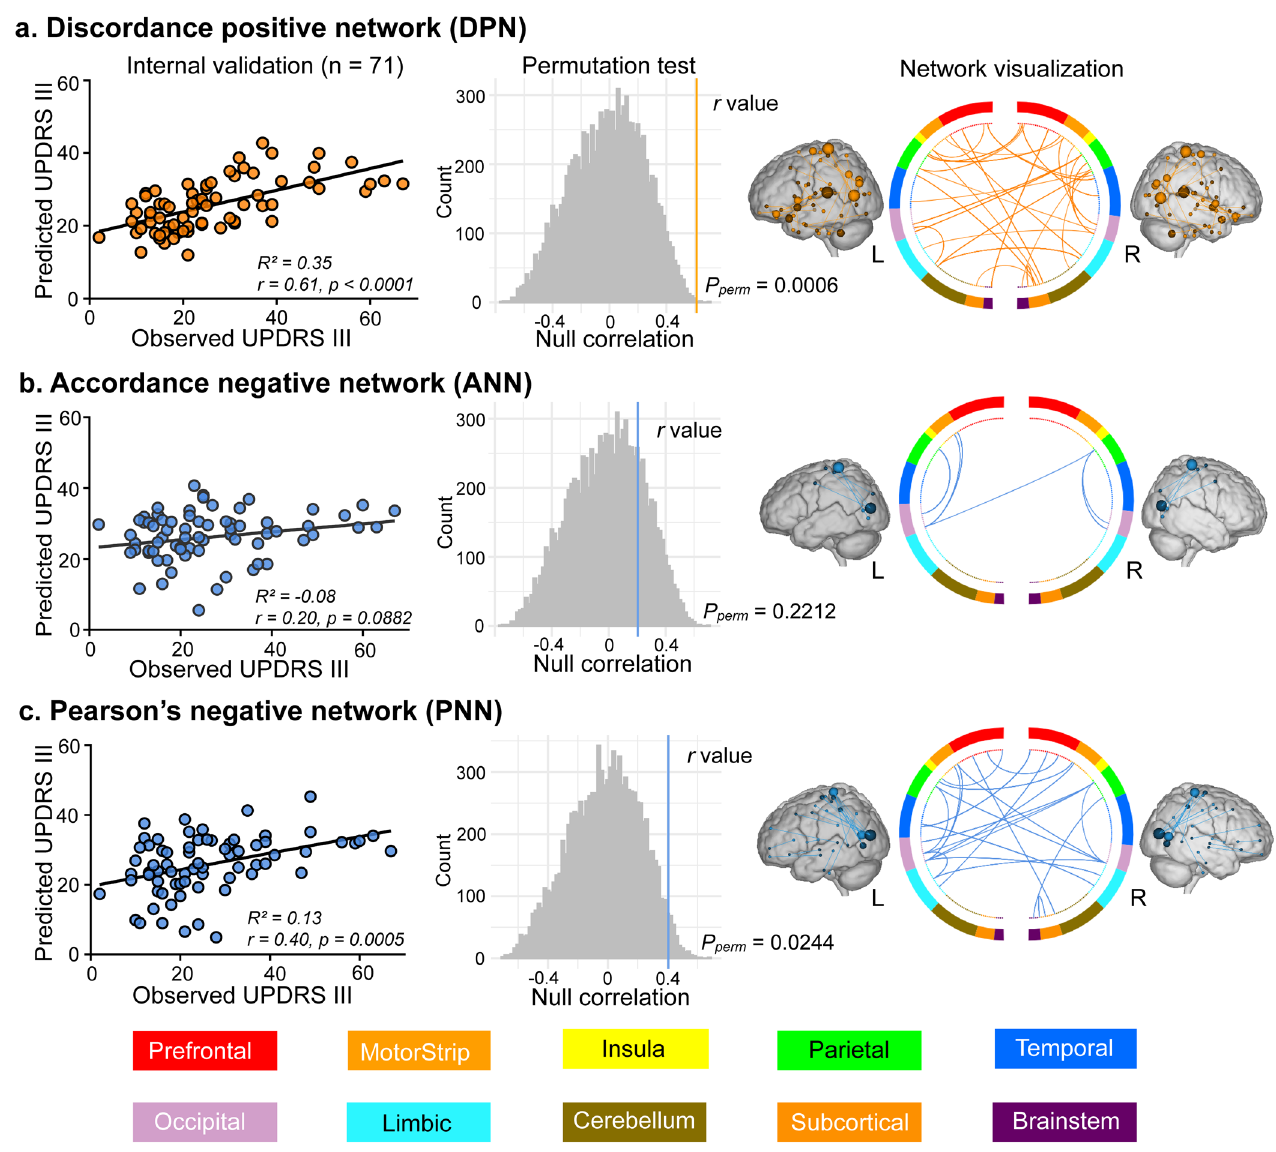
Fig. 2 Internal validation of predictive models and network visualization. Using the LOOCV method to obtain predicted scores, the evaluation of predictive performance was based on (1) the Pearson ’ s correlation between observed UPDRS III scores and predicted UPDRS III scores, and (2) the predicted R 2 (the left column). Permutation test was performed by comparing true r values (colored vertical lines in the middle column) with a null distribution of r values, yielding a signi fi cant effect for DPN and PNN models. Edges with signi fi cant ( P < 0.001) and robust (exceed 95% of iterations) dependency on UPDRS III scores were reserved in the predictive networks (the right column). The network visualization was completed with Bioimage Suite (https://bioimagesuiteweb.github.io/webapp/). The color bars at the bottom of this fi gure represent which brain parcellation the nodes are assigned to on the basis of a lobe scheme. L left hemisphere, R right hemisphere, LOOCV leave-one-out cross-validation, DPN discordance positive network, PNN Pearson ’ s negative